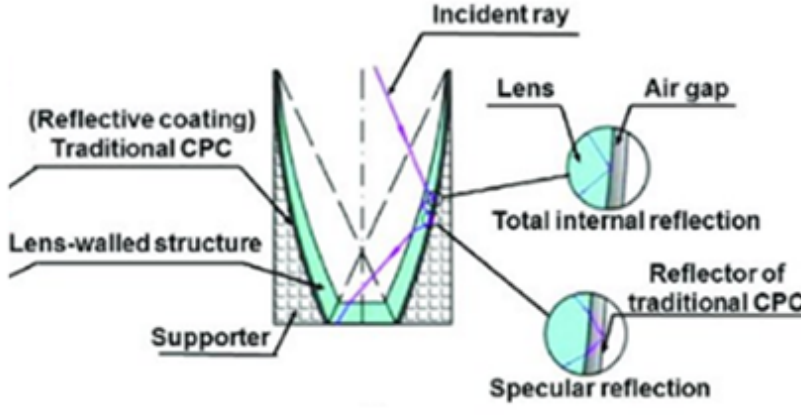
Figure 22. Structure of lens-walled CPC [34]. Reprinted from X. Ju et al., A review of concentrated photovoltaic-thermal (CPVT) hybrid solar systems with waste heat recovery (WHR), Science Bulletin 2017, 62, 1388–1426, with permission from